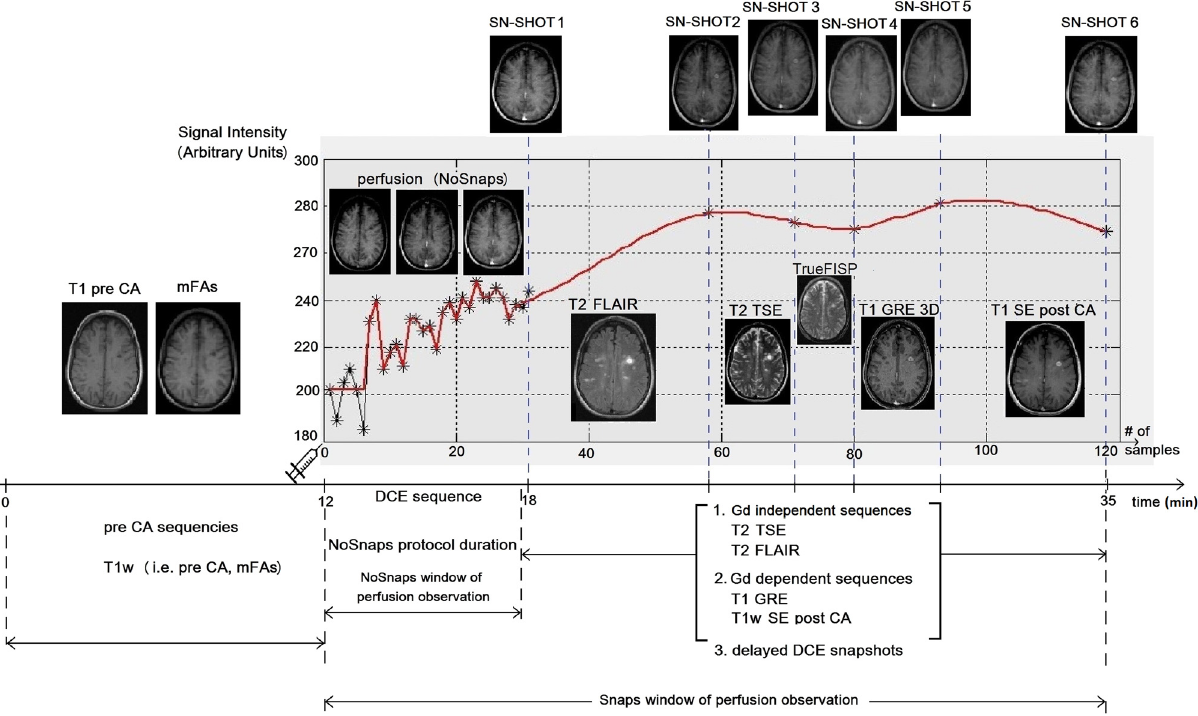
Figure 1: The time work fl ow of the MR protocol for patient number 2. Initially Gd - dependent sequences that do not need CA are acquired, i.e., mFA sequence. The DCE study starts at the 12th minute and lasts about 6 min, for the so - called NoSnaps protocol. Afterward, there were acquired Gd dependent ( i.e., T1 - w SE post CA ) and independent ( i.e., T2 FLAIR and DWI ) sequences, while in between them there were acquired six delayed DCE snapshots. In the right part of the fi gure, an exemplary SI time curve is shown in which the fi rst 30 asterisks are from the NoSnaps protocol, while the next six asterisks are the delayed DCE